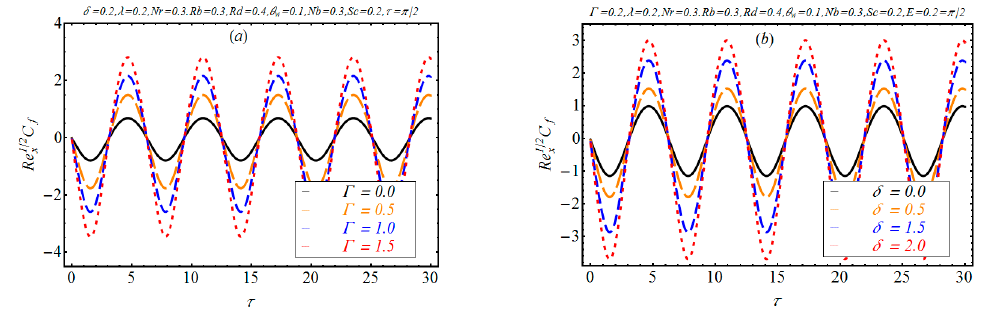
Figure 6. Variation in Re 1/2 x C f for ( a ) Γ and ( b ) δ